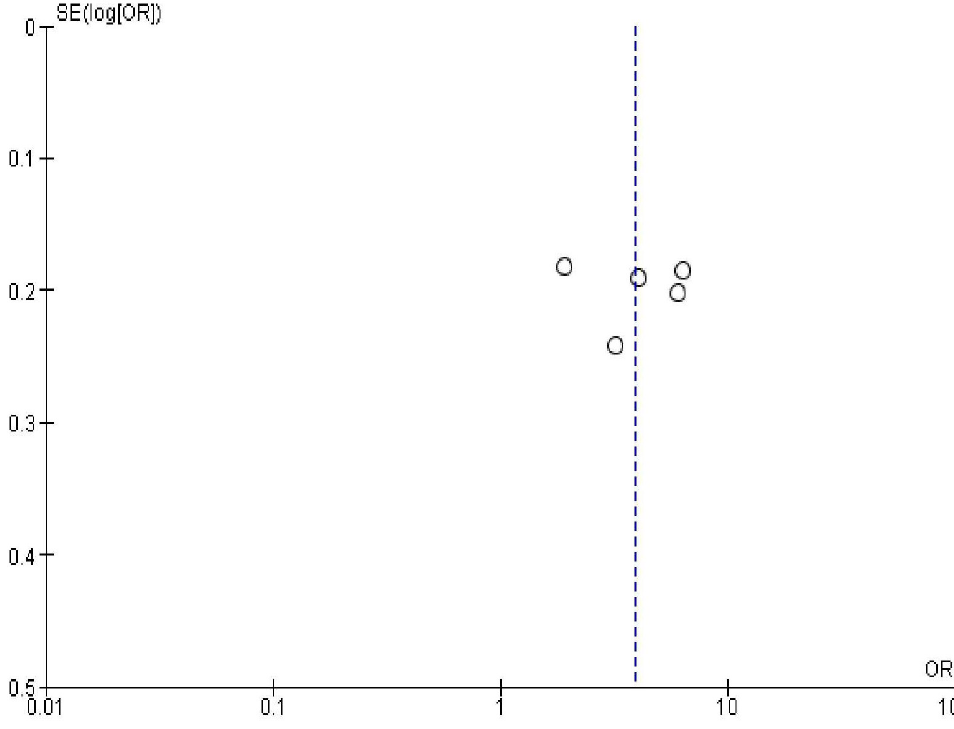
Fig 19. Publication bias on PPFP counseling during ANC visit.